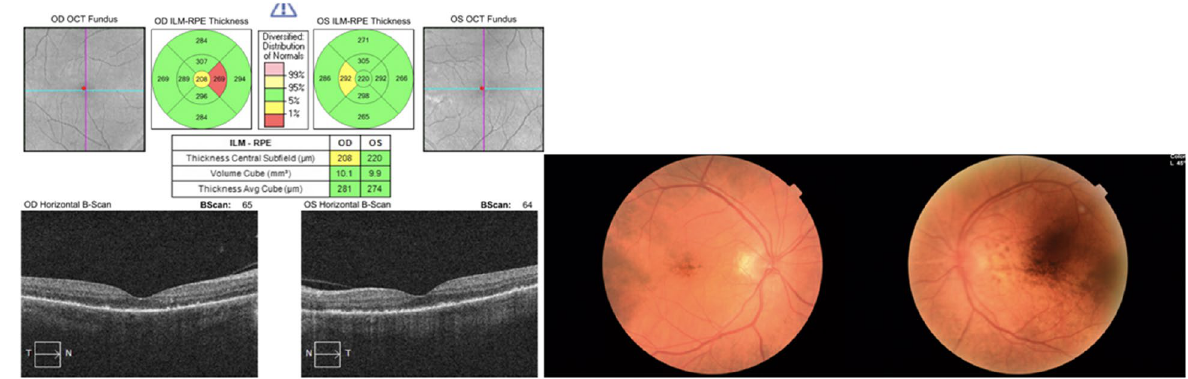
Fig. 8 07.10.2021: BCVA (0.4/0.4)